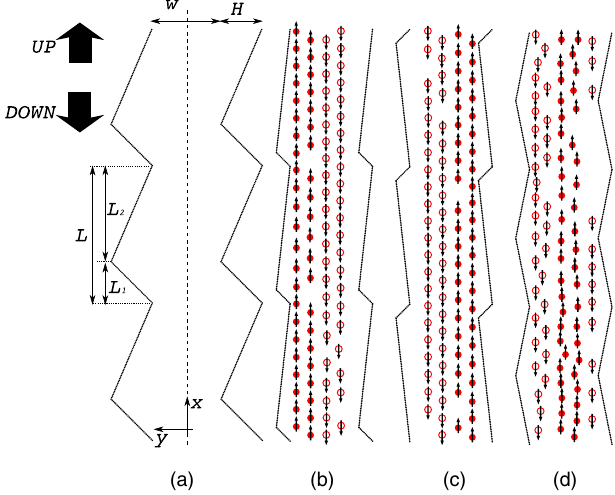
FIG. 1. Channel geometry and final configurations of pedes- trians for different asymmetry parameters. (a) Channel, of depth H and width W , through which a preferred flow orientation of particles is induced. The meaning of geometric parameters is indicated. (b – d) Typical configurations in the steady state, where the particles are keeping left in asymmetric wall channels but are mixed in symmetric ones. Upward movers (downward movers) are represented by full (hollow) particles. The velocity of each particle is indicated by arrows. The asymmetry parameter b ¼ L= 2 − L 1 takes the values b ¼ 8 in (b), b ¼ − 8 in (c), and b ¼ 0 ¼ 6 , and ρ ¼ 0 . 6 . The length unit is written in (d), for H ¼ 2 , v d in terms of particle diameter. Noise was not included in these